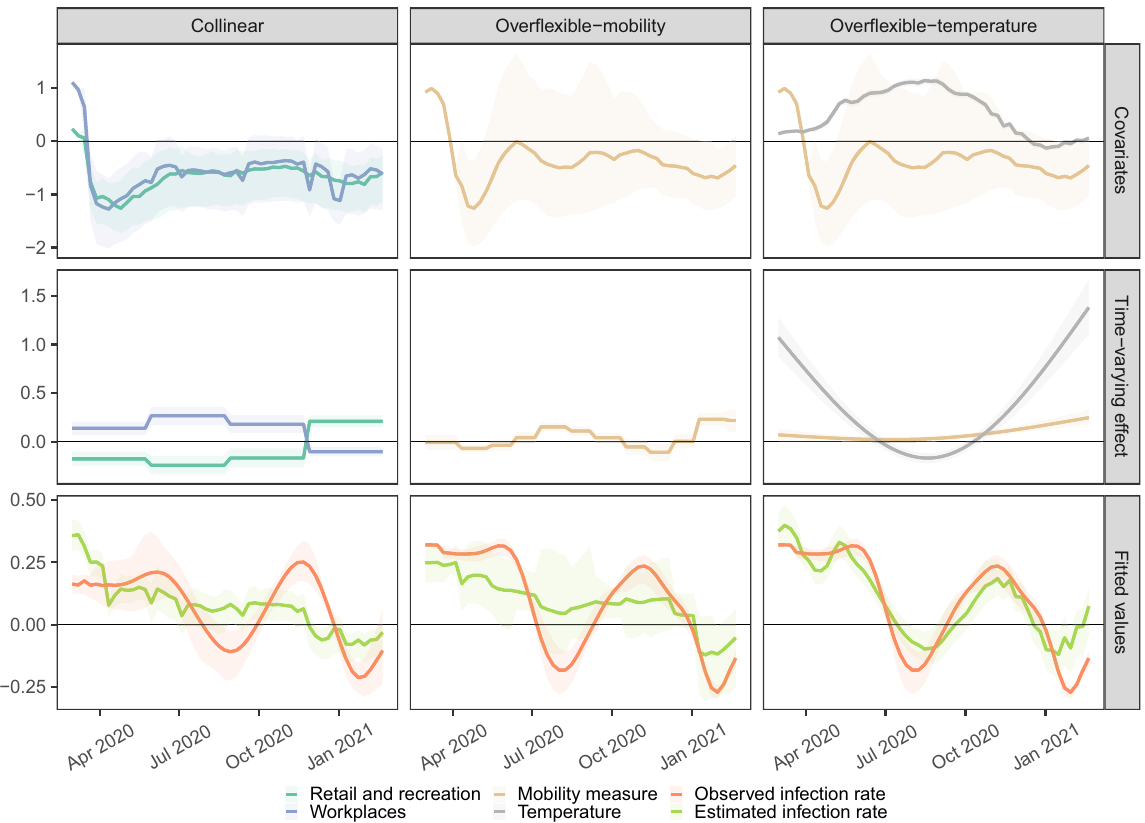
Fig. 3 Illustrative model shortcomings. Pitfalls due to collinearity in covariates (left), too much fl exibility in mobility (middle), and too much fl exibility by including temperature (right). Observed covariates and infection rates from two counties are used to demonstrate these limitations; the same data is used for both over fl exibile examples. Observed covariate values (top), estimated time-varying effects (middle), and fi tted and observed growth rates (bottom) are shown with median (solid lines) and 95% quantiles